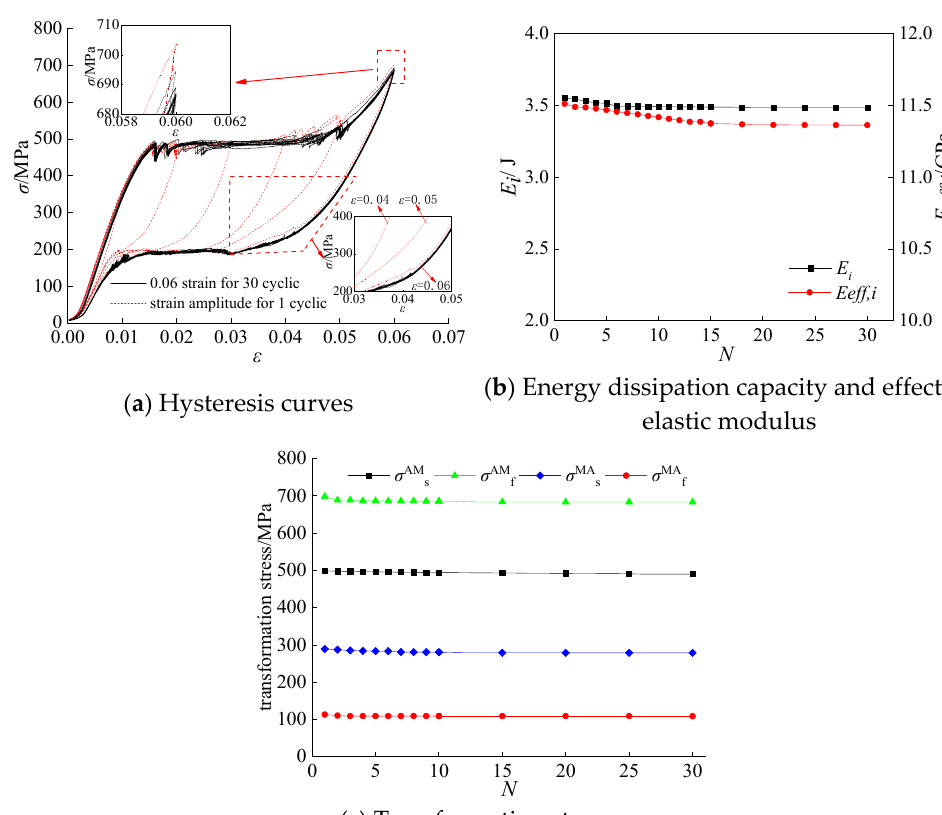
Figure 3. Effect of the number of cycles and strain amplitude on the mechanical properties of SMA wire.